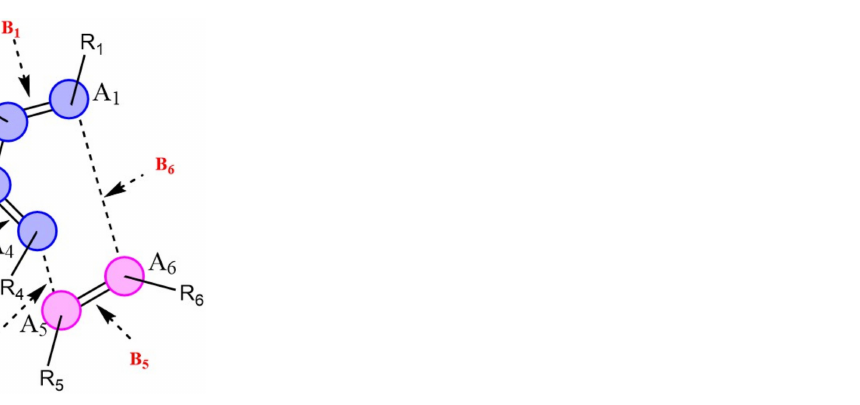
Figure 4. Reactive site of DA reactions. Atoms of the dienophile and diene are indicated in blue and pink,